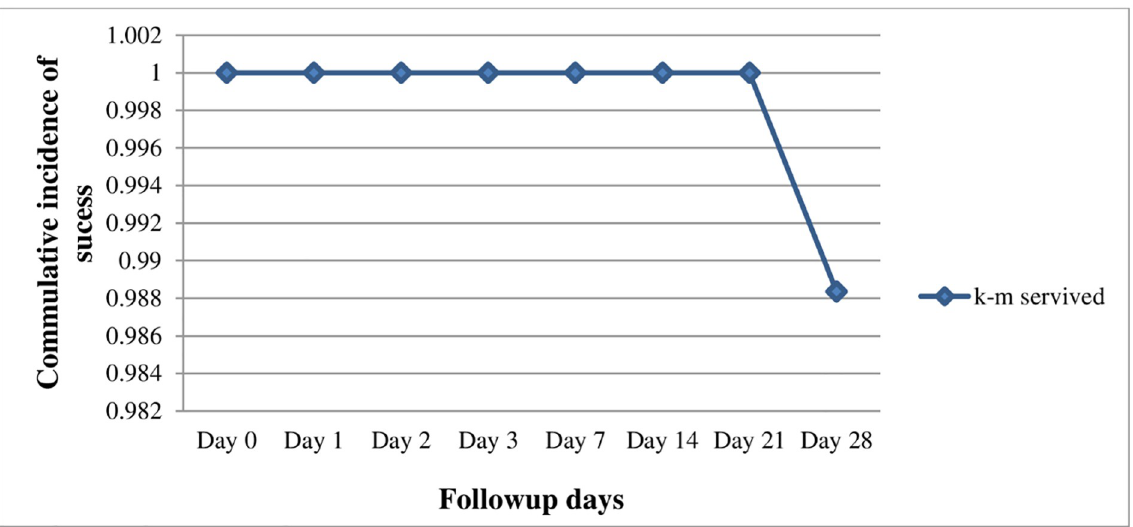
Fig 3. Kaplan-Meier survival curve of the study outcome in Shewa Robit Health Center, northeast Ethiopia from November 2020 to March 2021.